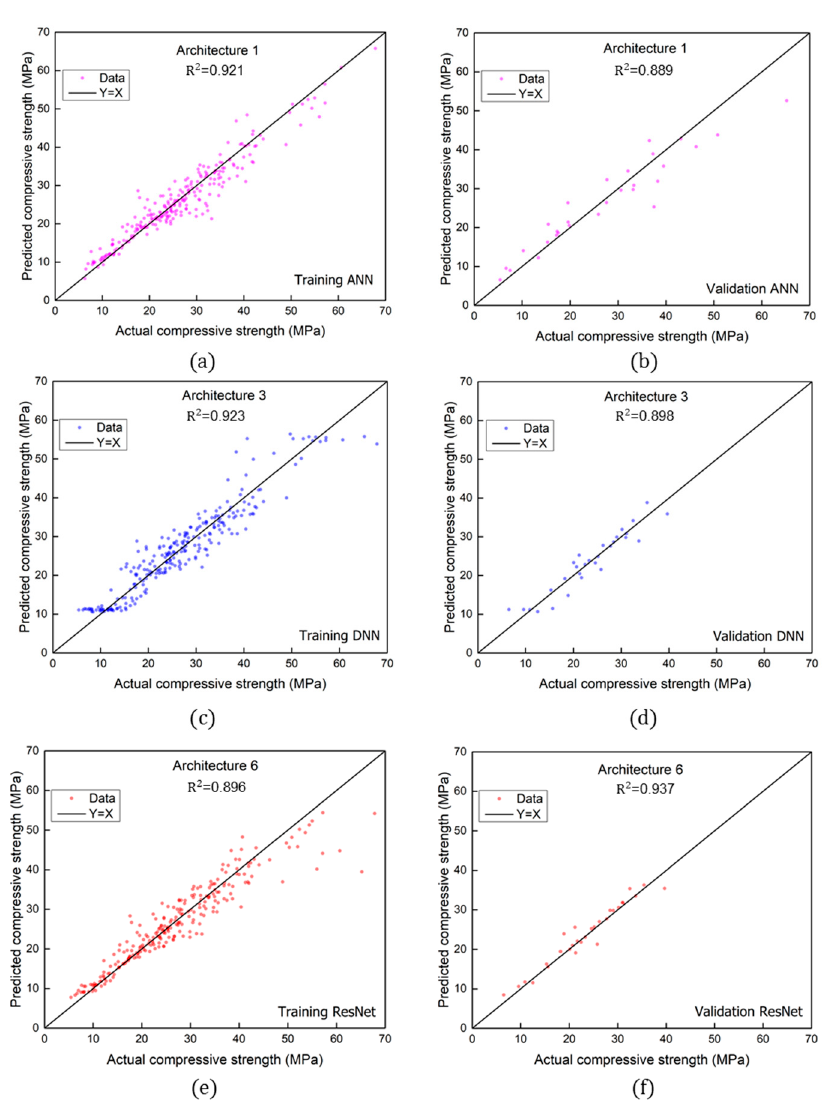
Figure 7. Correlation coefficients R of three proposed approaches: ( a ) training ANN; ( b ) validation ANN; ( c ) training DNN; ( d ) validation DNN; ( e ) training ResNet; ( f ) validation ResNet.